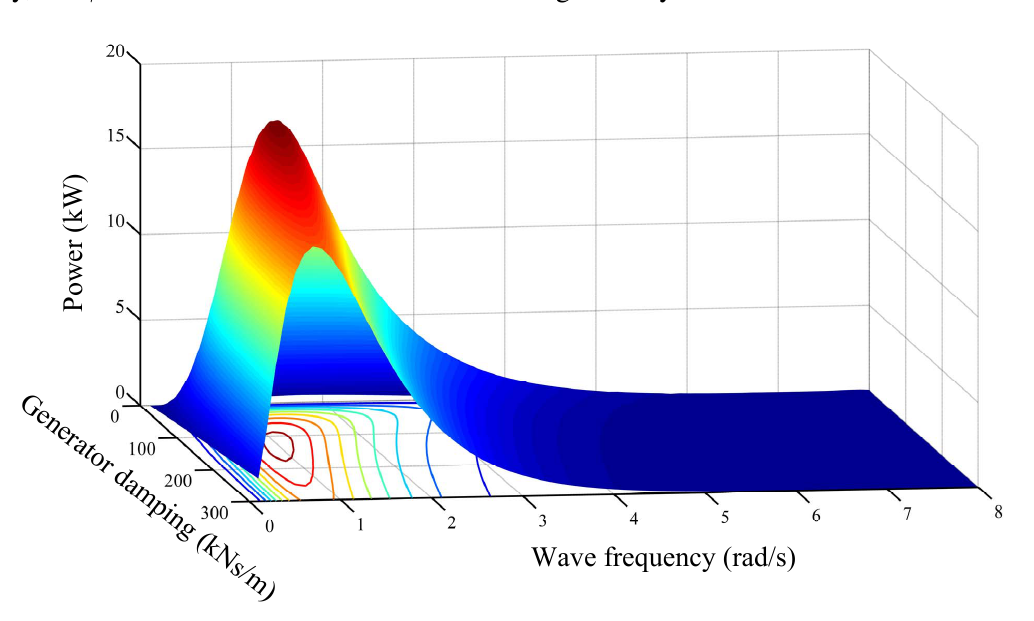
Figure 3. Theoretical absorbed power studied in the frequency domain, for a cylindrical buoy with radius a = 2 m. The theoretical maximum power was found to be 19 kW for this buoy, for γ = 124 kNs/m and at a wave oscillating velocity of 1.0 rad/s.